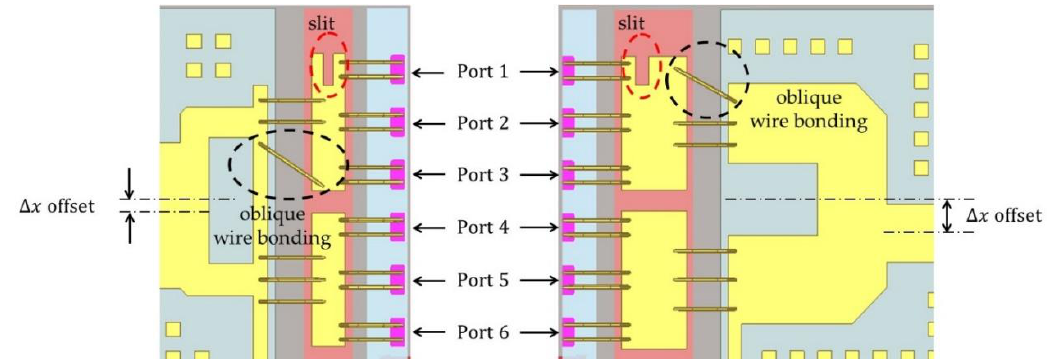
Figure 4. Input and output matching patterns with the slit, oblique wire bonding and asymmetric T-junction.